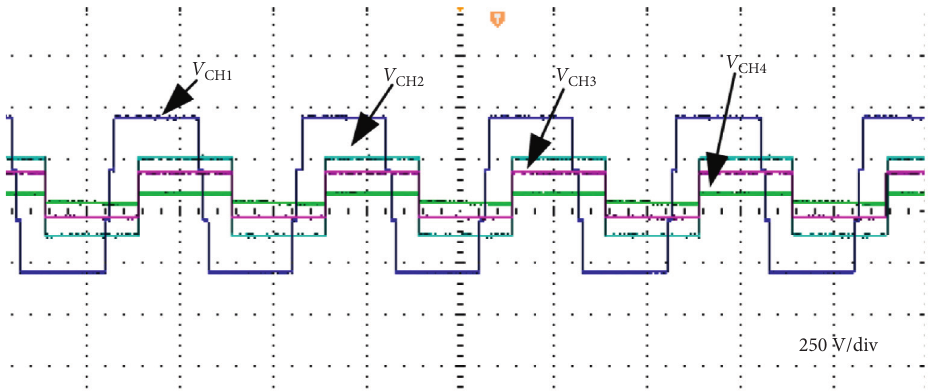
Figure 19: High-frequency link waveforms of each port.